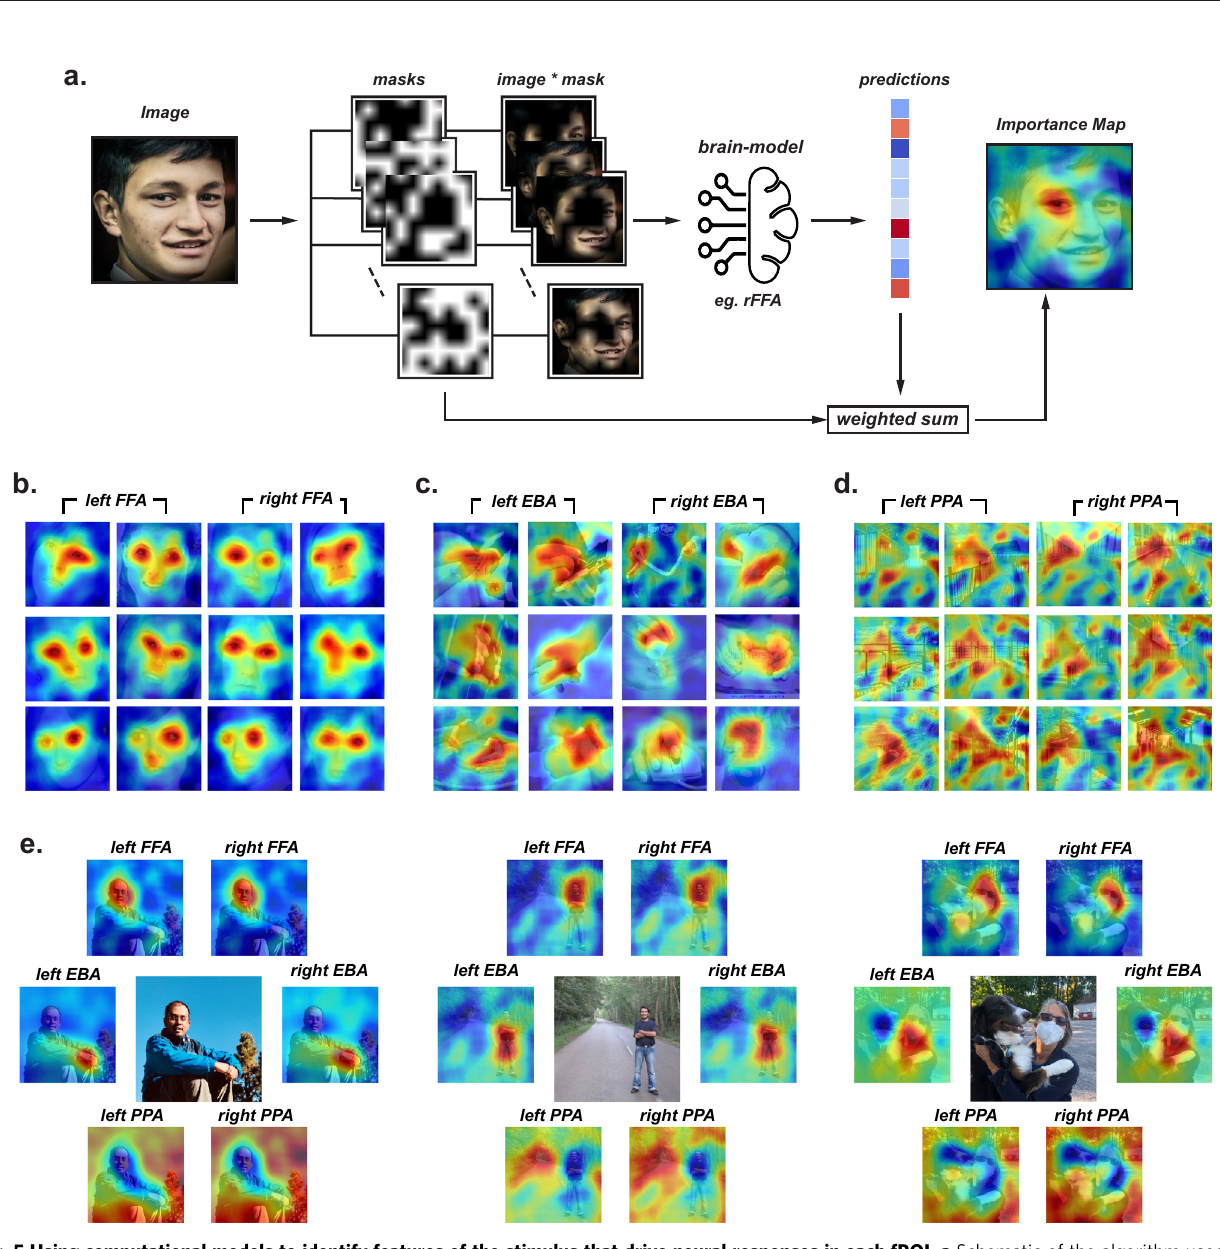
Fig. 5 Using computational models to identify features of the stimulus that drive neural responses in each fROI. a Schematic of the algorithm used to generate importance maps. We convolve each image with 2000 masks (left) and run the masked images through our brain model for each fROI to generate the predicted response for each image. The importance map (right) is the generated by taking a weighted sum of the masks with these predicted responses. Permission was obtained from the person in the photograph to publish the image used in this fi gure. b Importance maps for the left and right FFA for the images predicted to generate high responses. The warm colors on the overlaid colormaps indicate regions that most strongly activate the FFA and cool colors indicate regions that do not activate the FFA. c Same as b but for left and right EBA. d Same as b but for left and right PPA. e Importance maps for three representative photographs with faces, bodies and background scenes and importance maps for each fROI. Permission was obtained from the persons in the photographs to publish the image used in this fi